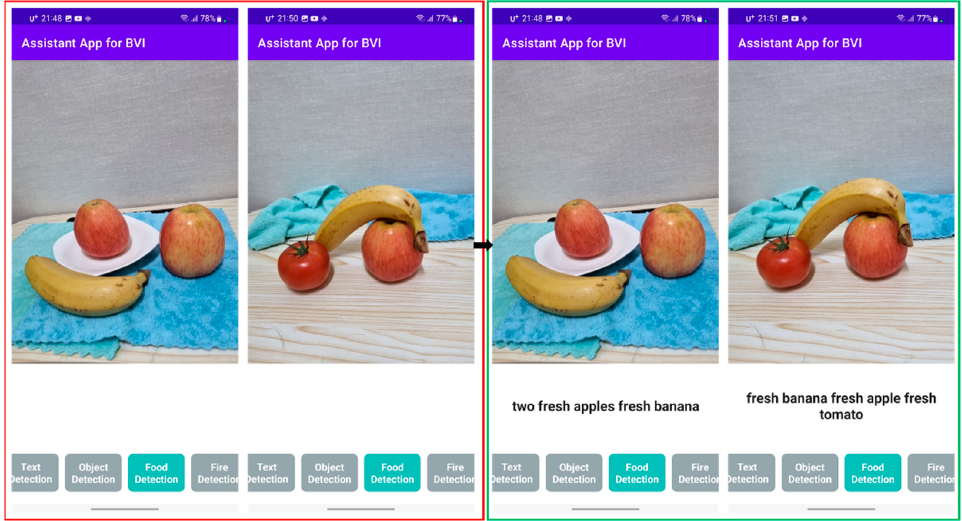
Figure 10. Mobile application of fruit and vegetable classification system for BVI people.